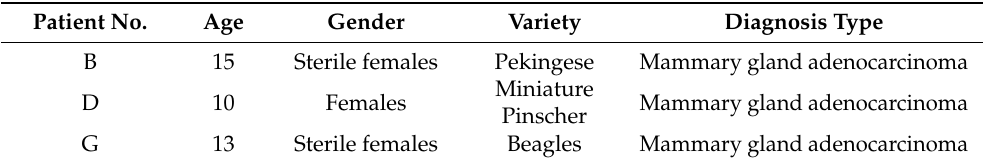
Table 2. The information for patients with canine mammary tumours subjected to a circRNA expression profile sequencing